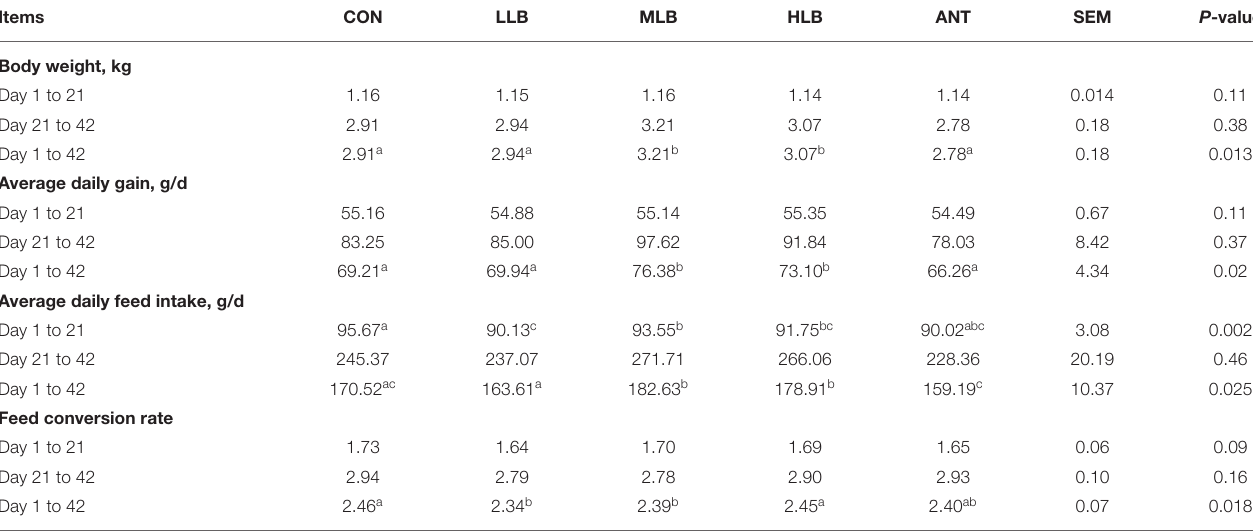
TABLE 2 | Effects of B. licheniformis and aureomycin on growth performance of Pekin ducks 1 . Items Body weight, kg